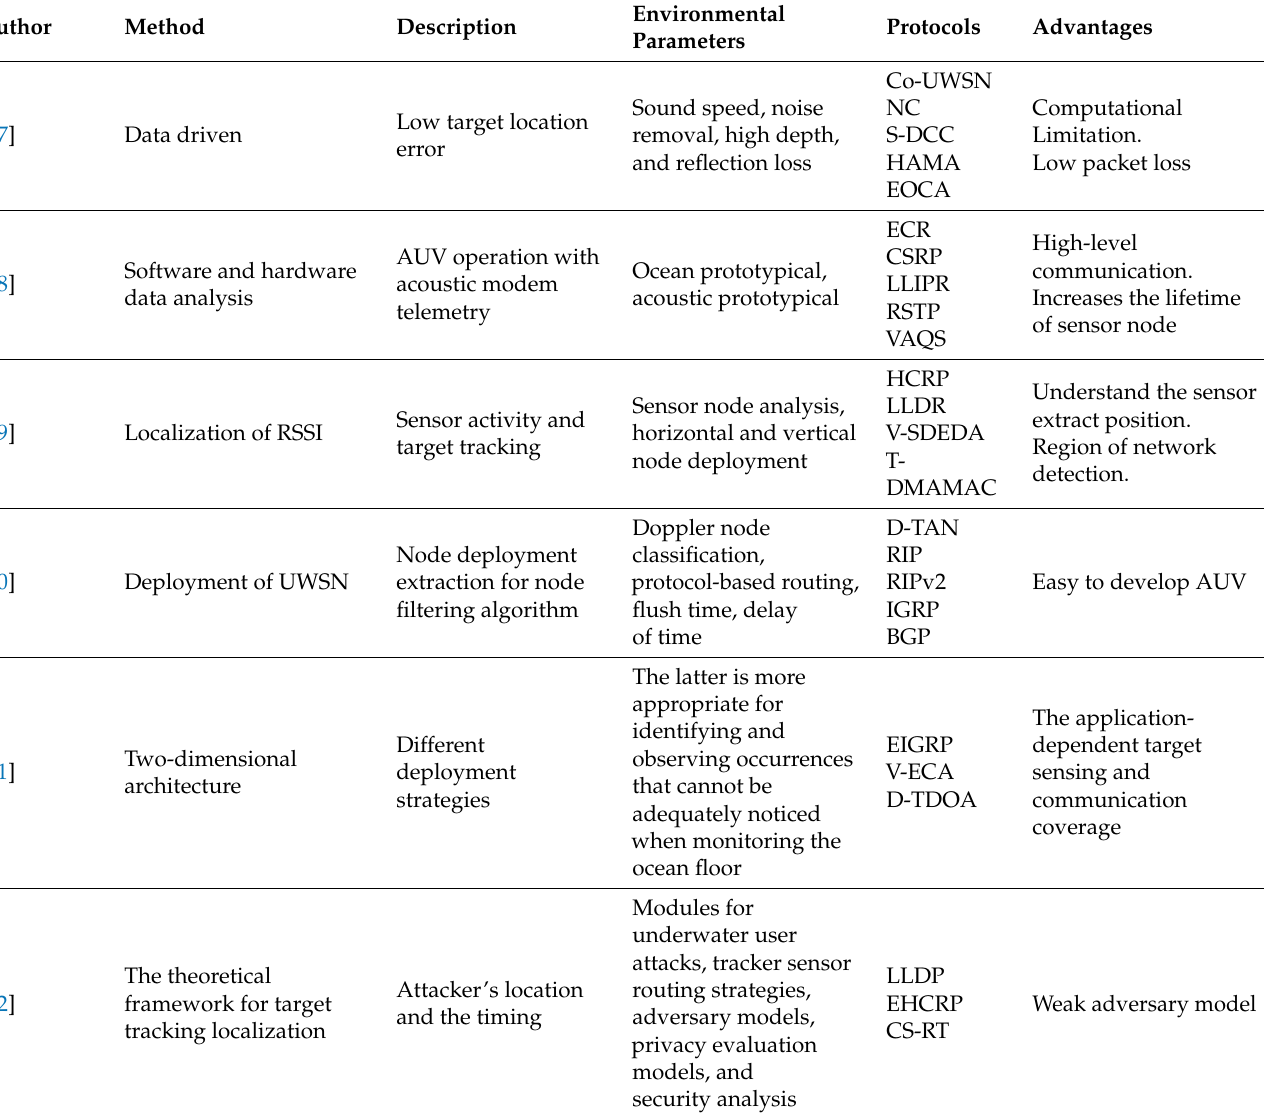
Table 1. Related paper